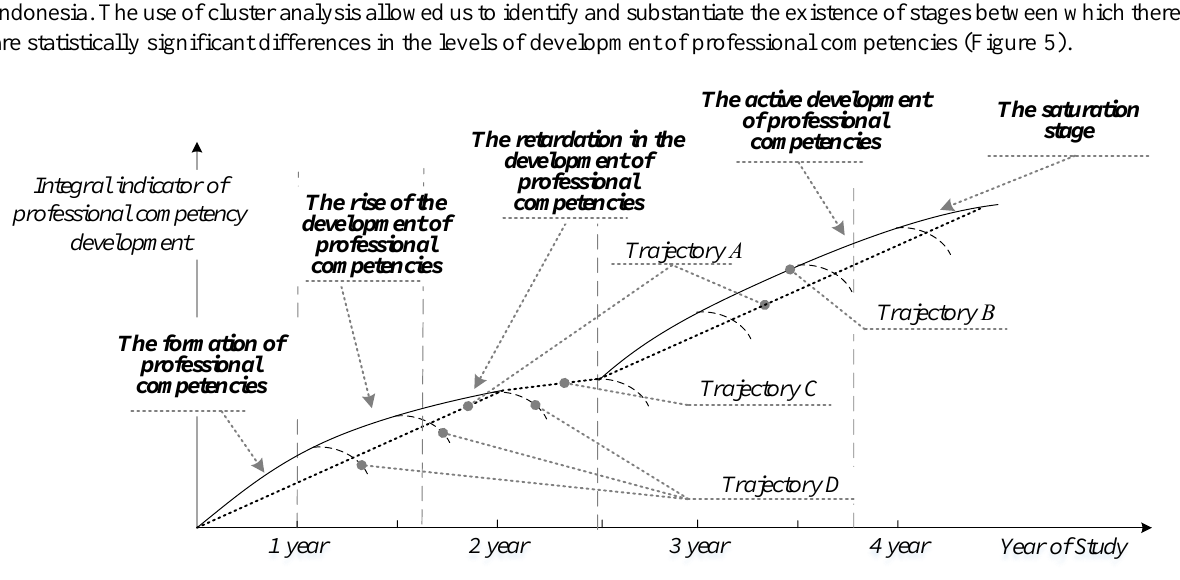
Figure 5. Stages of professional competency development among Russian and Indonesian university students: Trajectory A - general upward dynamics of students' professional competency development; Trajectory B - individual dynamics of students' professional competency development; Trajectory C - dynamics of students' professional competency development under the influence of COVID-19 pandemic; Trajectory D - descending dynamics of professional competency development for students expelled from